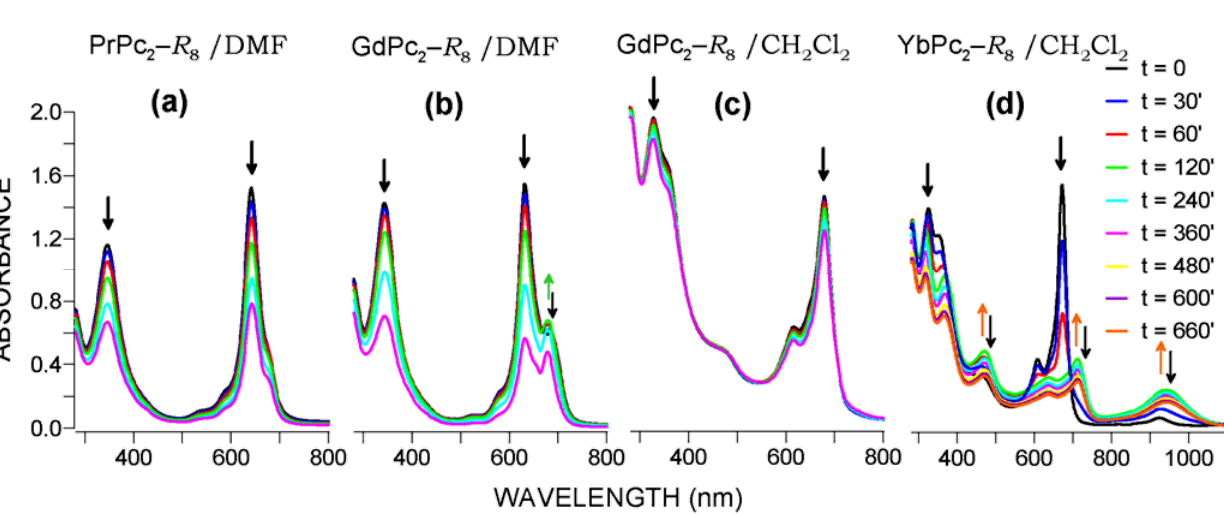
Figure 10. Photolysis of LnPc - R in DMF and CH Cl under constant UV irradiation 2 8 2 2 ( λ = 352 nm, 300 μ W·cm − 2 ) featuring diverse types of reaction kinetic; total irradiation time, t = 360 min (660 min for Yb). Arrows indicate the trend of changes in the solution composition. Development of the green and orange forms is highlighted by the respective colors while their extinction is indicated by the black